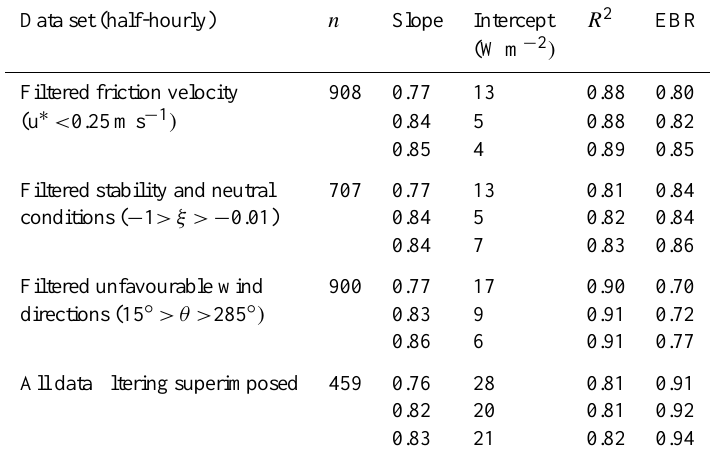
Table 3. Parameters of the linear regression between the turbulent flux ( H+LE ) and the available energy, as well as the Energy Balance Ratio (EBR), after several independent, non-cumulative filtering processes, and after all the data filtering superimposed. For each case the available energy considered is: R n - G 0 (top line), R n -G (middle line), and R n -G-S (bottom line). Data set (half-hourly) n